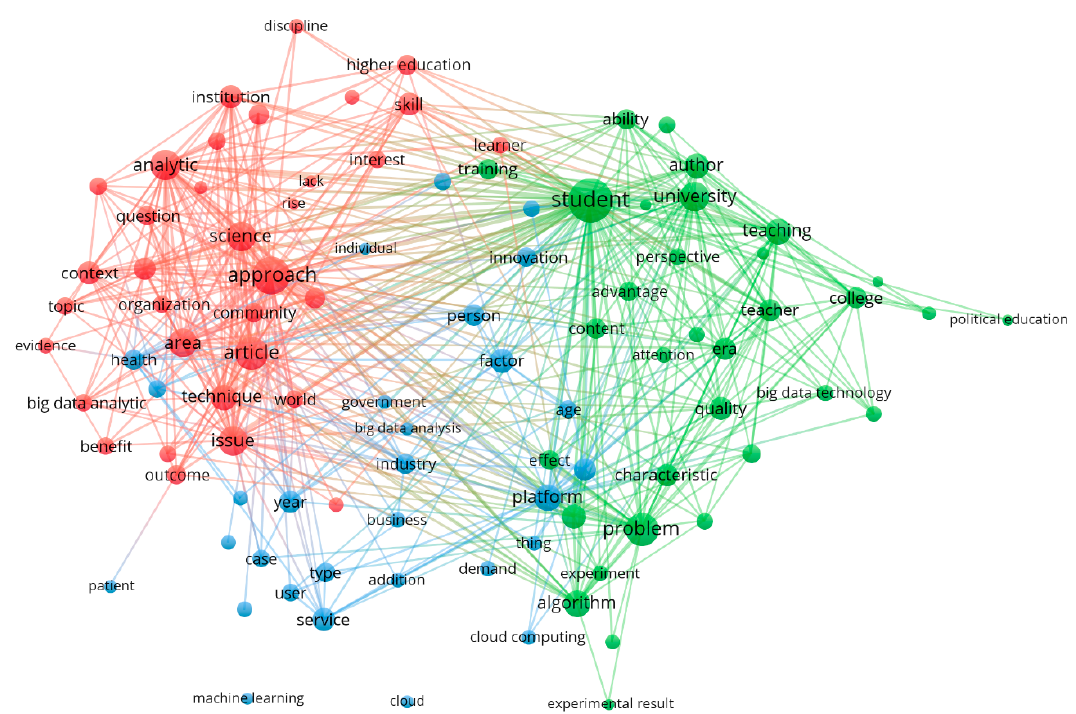
Figure 3. Networks map between the keywords of articles published on Big Data in education.